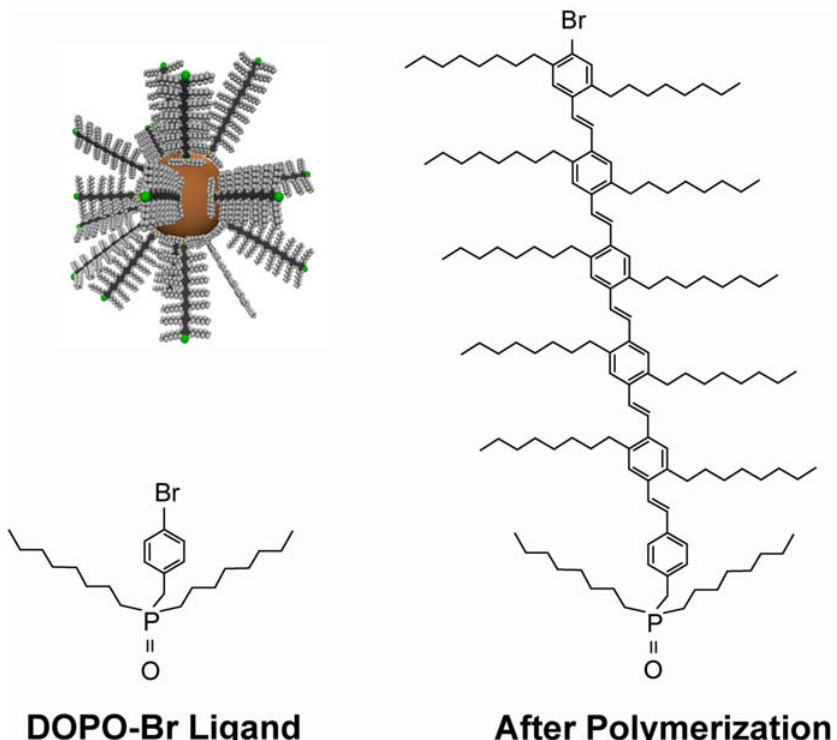
Figure 4. Top Left: CdSe quantum dot with oligo-(phenylene vinylene) ligands. Bottom Left: DOPO-BR ligand prior to polymerization reaction. Right: oligo-(phenylene vinylene) ligand after polymerization from